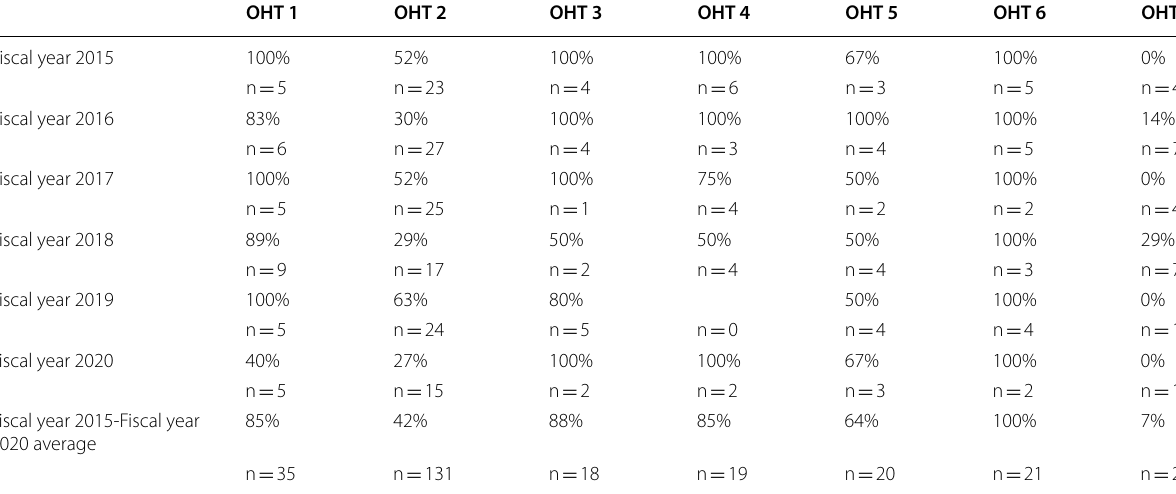
Table 2 Percentage of PMA approvals that included PRO instruments by fiscal